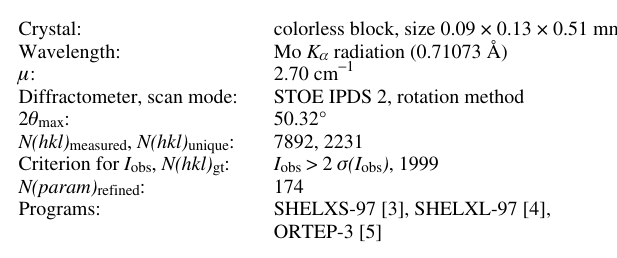
Table 1. Data collection and handling.